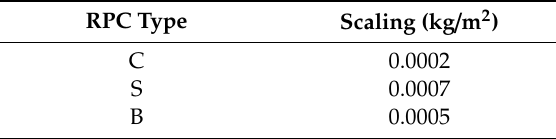
Table 6. RPC concrete frost resistance (kg / m 2 )